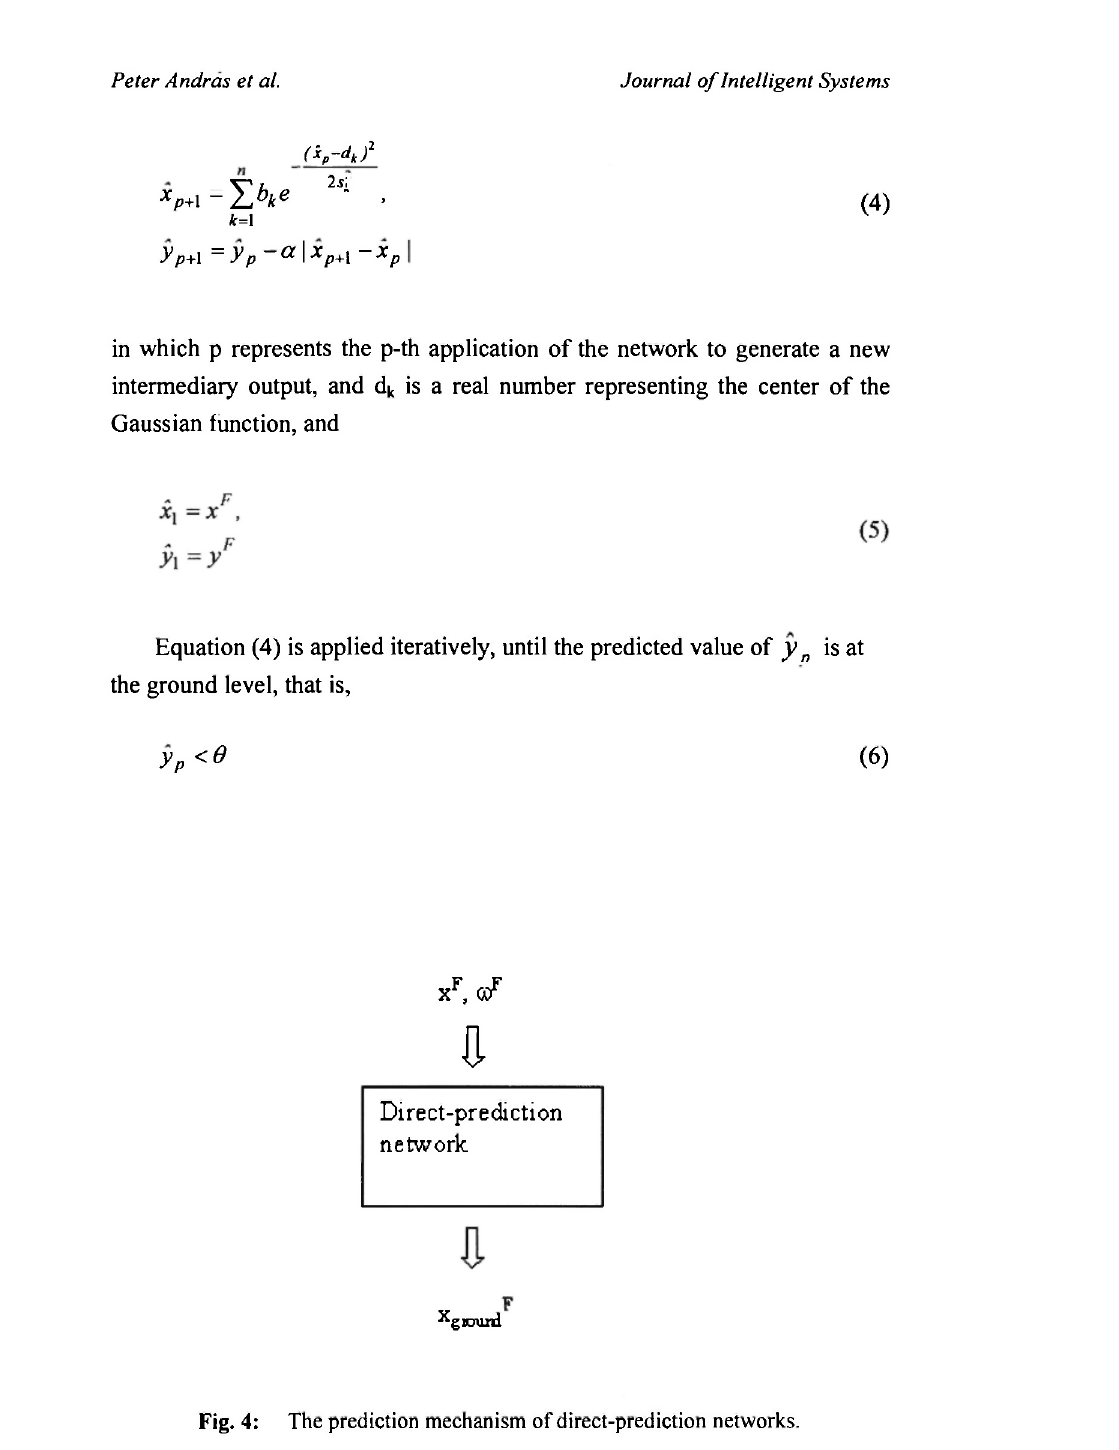
Fig. 4: The prediction mechanism of direct-prediction